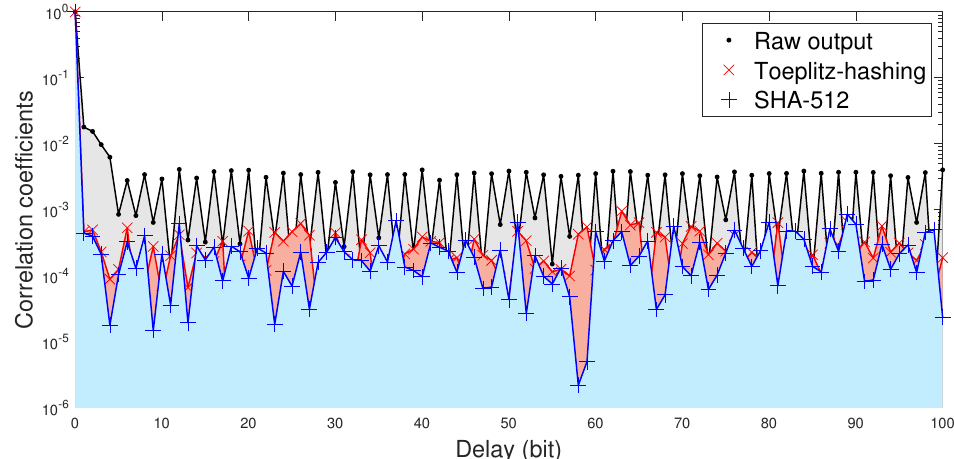
Figure 10. Correlation coefficients for the Raw, Toeplitz-hashed, and SHA-512 hashed outputs for 10 7